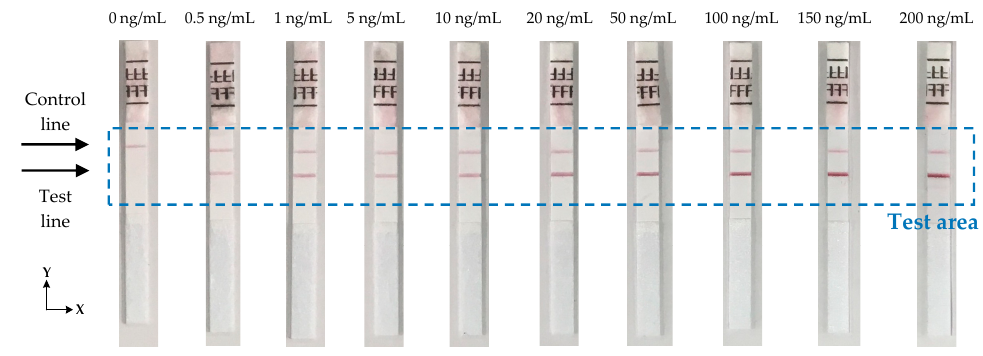
Figure 8. Photographs of the LFIAs in various concentrations that have been used for the testing of the system.